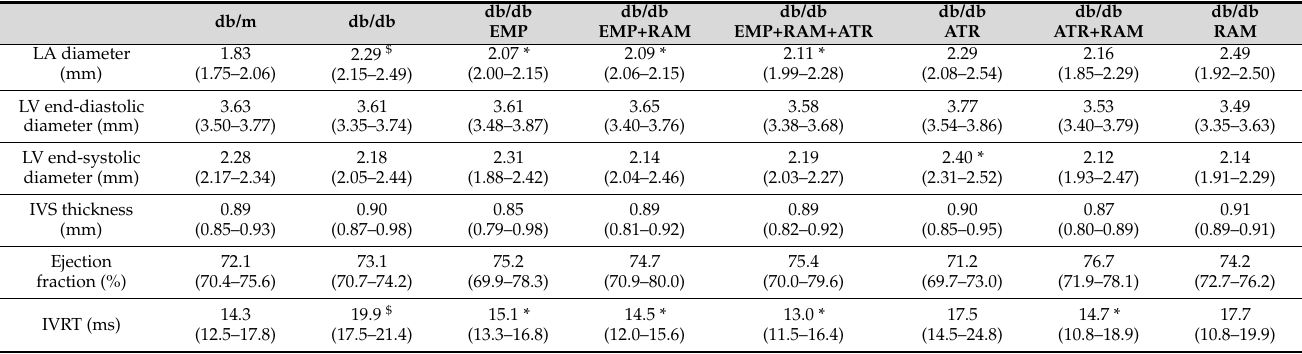
Table 2. Echocardiographic measurements after 8 weeks of treatment in vehicle-treated db/m mice, vehicle-treated db/db mice, and db/db mice treated with empagliflozin, atrasentan, ramipril, or their